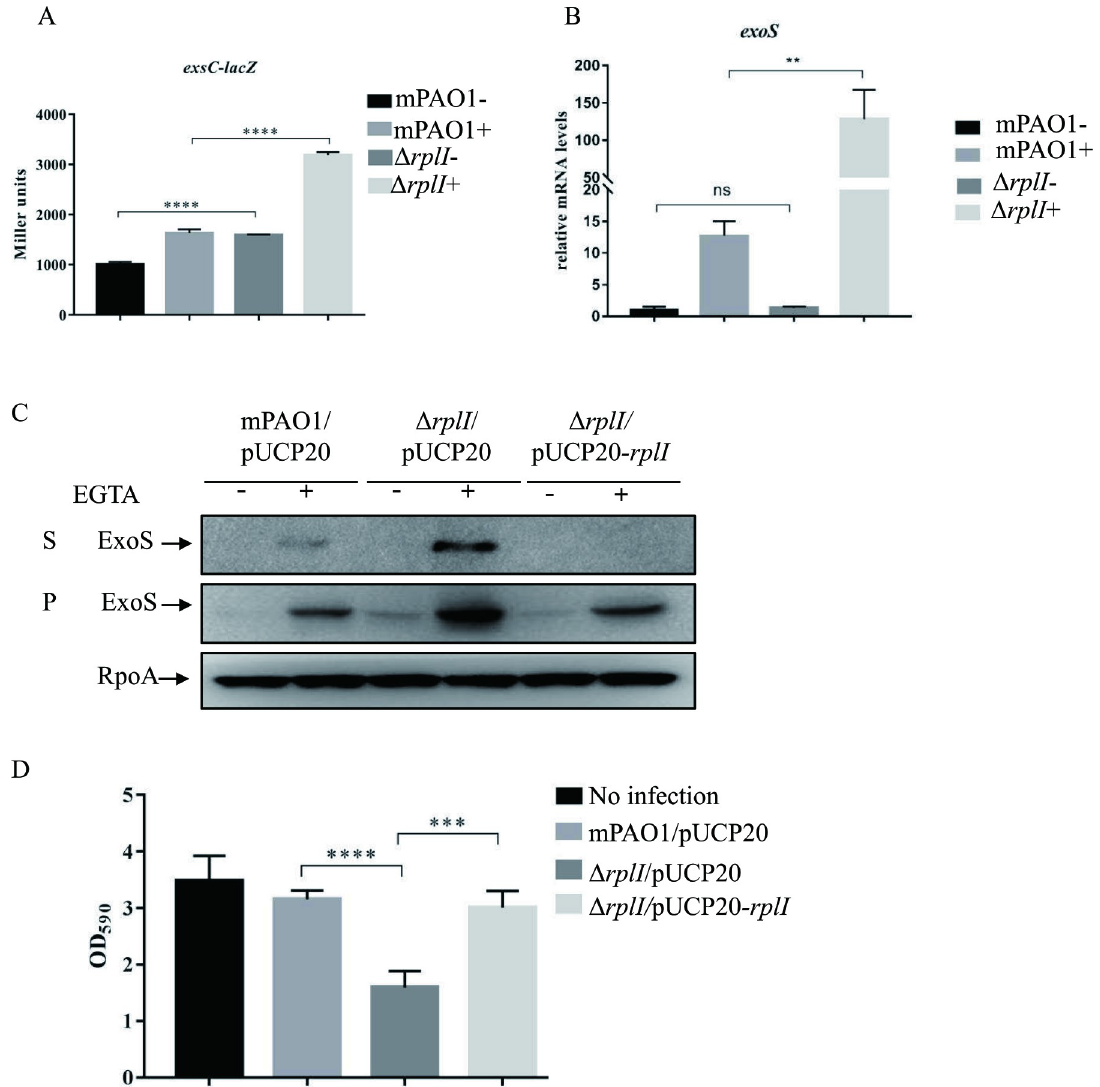
Fig 1. RplI represses T3SS expression and cytotoxicity. (A) mPAO1 and Δ rplI containing the P - lacZ transcriptional fusion were exsC grown to an OD 600 of 1.0 in LB with (+) or without (-) 5 mM EGTA and subjected to β -galactosidase assays. Each assay was performed in triplicate, and the error bars indicate standard deviations. ���� P < 0.0001 compared with wild-type mPAO1 by Student’s t test. (B) Relative exoS mRNA levels in the mPAO1 and Δ rplI strains. Total RNA was isolated under T3SS inducing (+) and non-inducing (-) conditions with 5 mM EGTA, and the exoS mRNA levels were determined by real-time qPCR using rpsL as the internal control. ns, not significant, �� P < 0.01, by Student’s t test. (C) Expression and secretion of ExoS in mPAO1/pUCP20, Δ rplI /pUCP20 and Δ rplI /pUCP20 - rplI . Bacteria were cultured to an OD 600 of 1.0 in LB medium with or without 5 mM EGTA. Proteins in supernatants (S) and pellets (P) from equivalent bacterial cells were loaded onto 12% SDS-PAGE gels and probed with an antibody against ExoS or an anti-RpoA antibody. The data shown represent the results from three independent experiments. (D) Cytotoxicity of mPAO1/pUCP20, Δ rplI / pUCP20 and Δ rplI /pUCP20 -rplI . HeLa cells were infected with the indicated strains at an MOI of 50. Three hours post infection, cells attached to the 24-well plate were washed with PBS and stained with crystal violet. The cell-associated crystal violet was dissolved in ethanol and quantified by measuring the OD 590 . HeLa cells with no bacterial infection served as a control. ��� P < 0.001, ���� P < 0.0001 by Student’s t